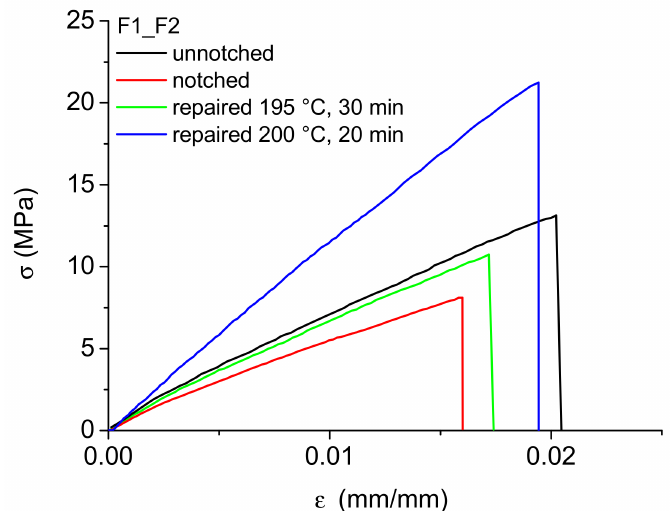
Figure 5. Flexural curves of poly-butylene terephthalate (PBT) without notch, notched, and healed with di ff erent recovery conditions. Table 2. Flexural results on PBT samples before and after healing with di ff erent recovery conditions. F1_F2 System